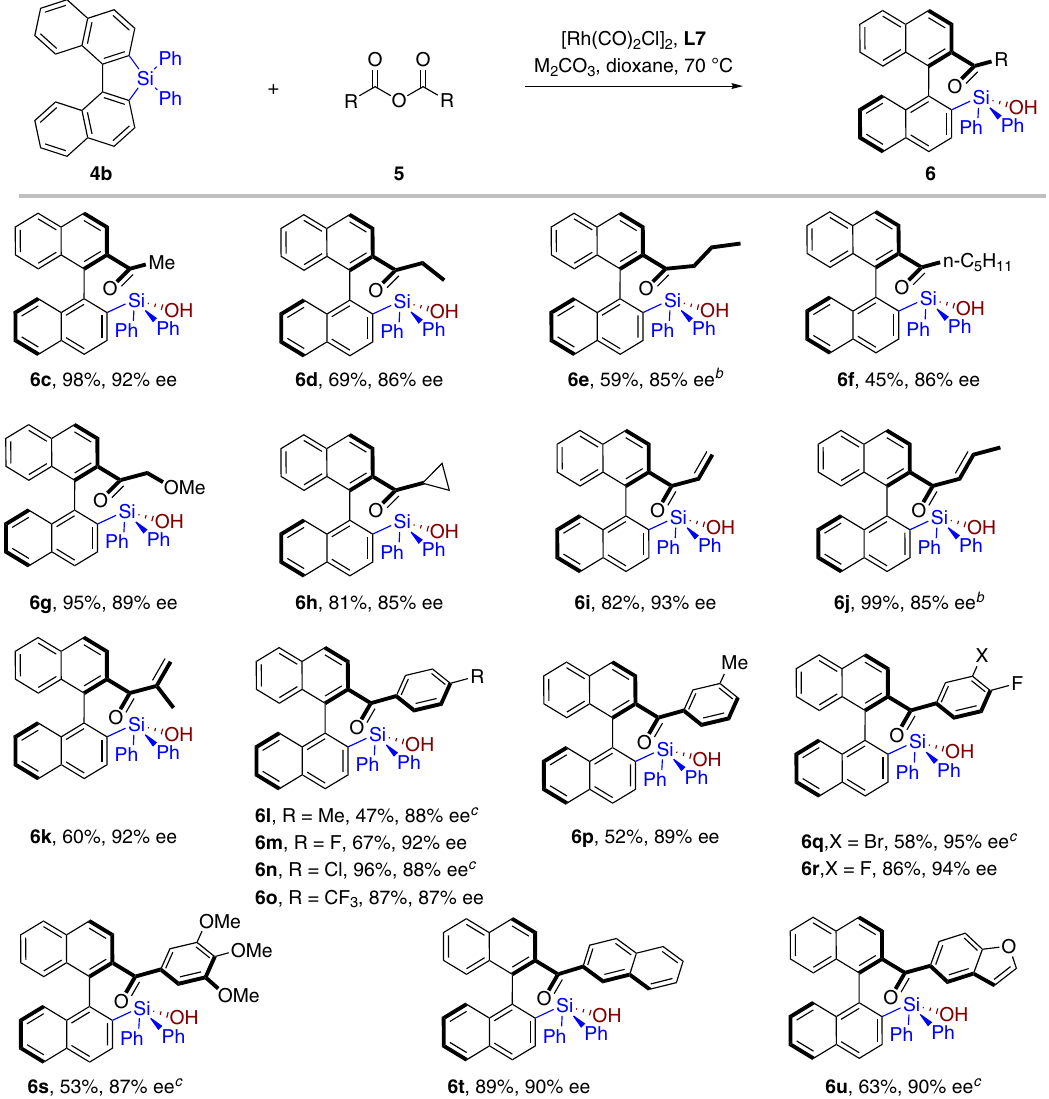
Fig. 3 Substrate scope a . a Reaction conditions: sila fl uorene 4b (0.20 mmol) and acid anhydrides (0.30 mmol, 1.5 equiv), [Rh(CO) 2 Cl] 2 (0.005 mmol, 2.5 mol%), L7 (0.0125 mmol, 6.25 mol%), and base (30 mol%, Na 2 CO 3 for aliphatic anhydride, Cs 2 CO 3 for aromatic anhydride) in 1,4-dioxane (4.0 mL) at 70 °C for 24 h. b L1 was used as the ligand. c The reaction time is 48